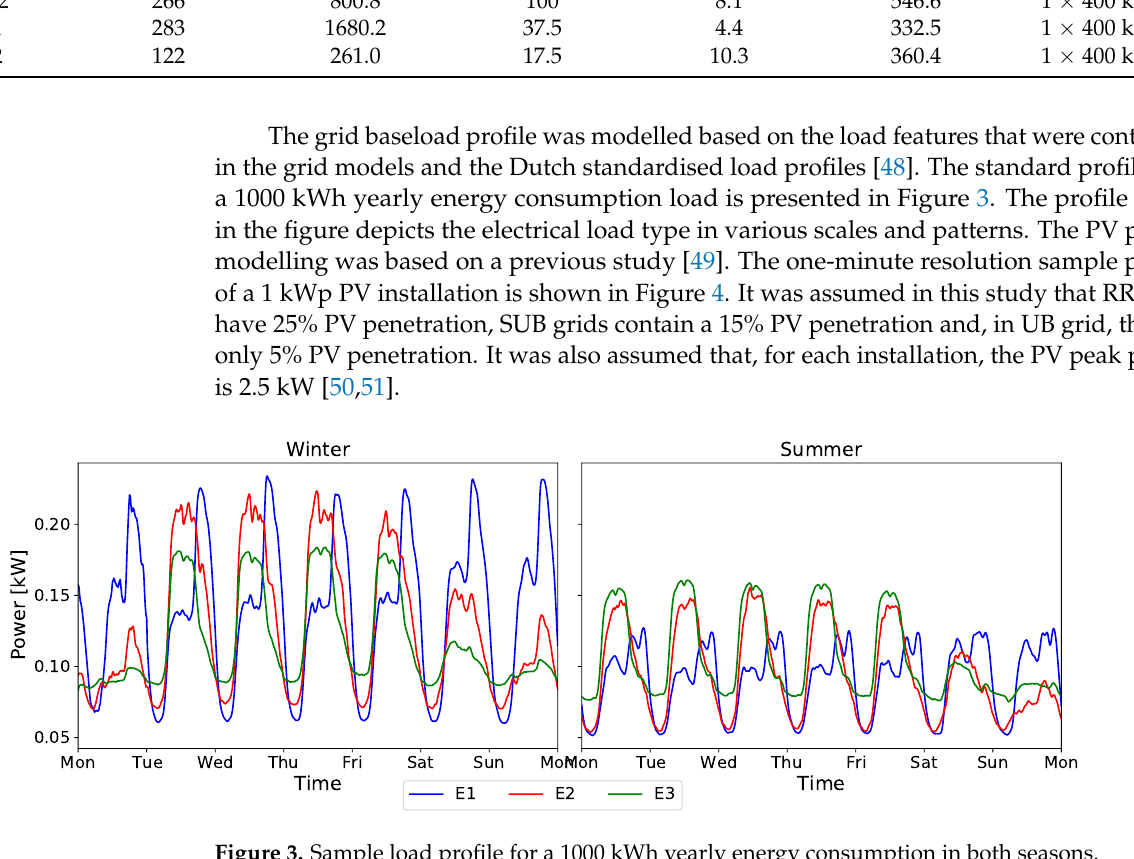
Figure 3. Sample load profile for a 1000 kWh yearly energy consumption in both seasons.